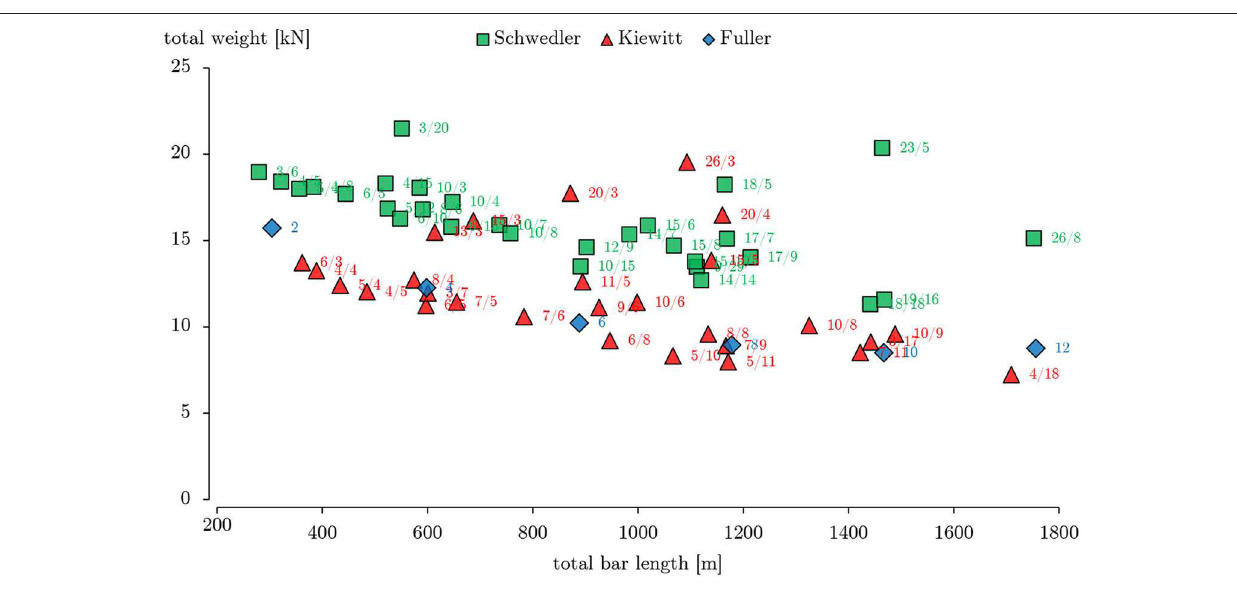
FIGURE 5 | Minimized weight of Schwedler, Kiewitt, and geodesic domes if all their members are restricted to have the same cross-sectional